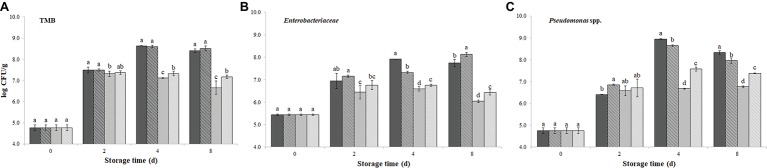
Growth of total mesophilic bacteria (TMB) (A), Enterobacteriaceae
(B), and Pseudomonas spp. (C), evaluated up to 8 days of storage at 4 ± 1°C, on burger patties incorporating prickly pear extract (PPE) and encapsulated prickly pear extract (Encaps-PPE). Controls were made incorporating sterile distilled water (SDW) or encapsulated sterile distilled water (Encaps-SDW). Columns at the same storage time (0, 2, 4, and 8 days) followed by different letters are significantly different according to Fisher’s least significant difference test (p < 0.05). Vertical bars indicate the standard deviation of the mean.  SDW  Encapsulated-SDW  PPE  Encapsulated-PPE.